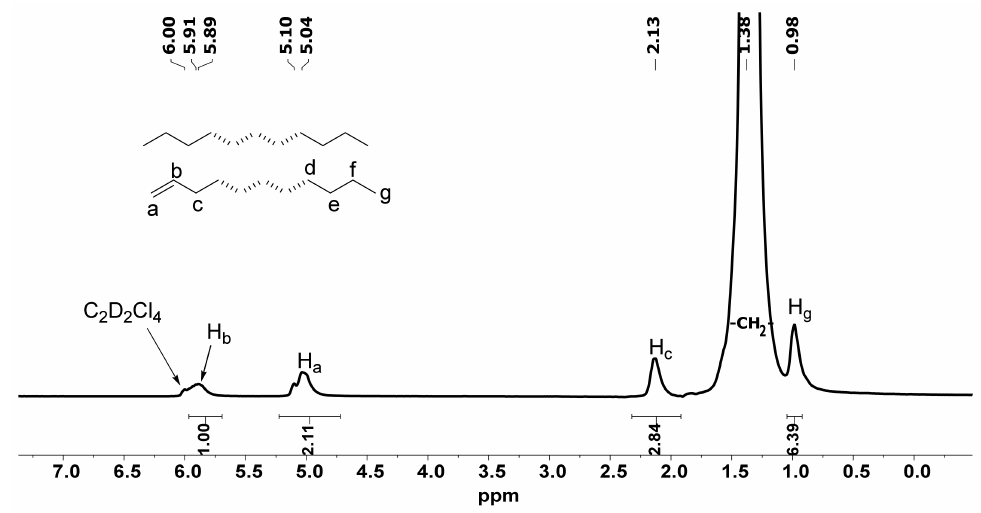
Figure 11. The 1 H-NMR spectrum of the polyethylene obtained with Co1 /MMAO (Table 3, entry 9).